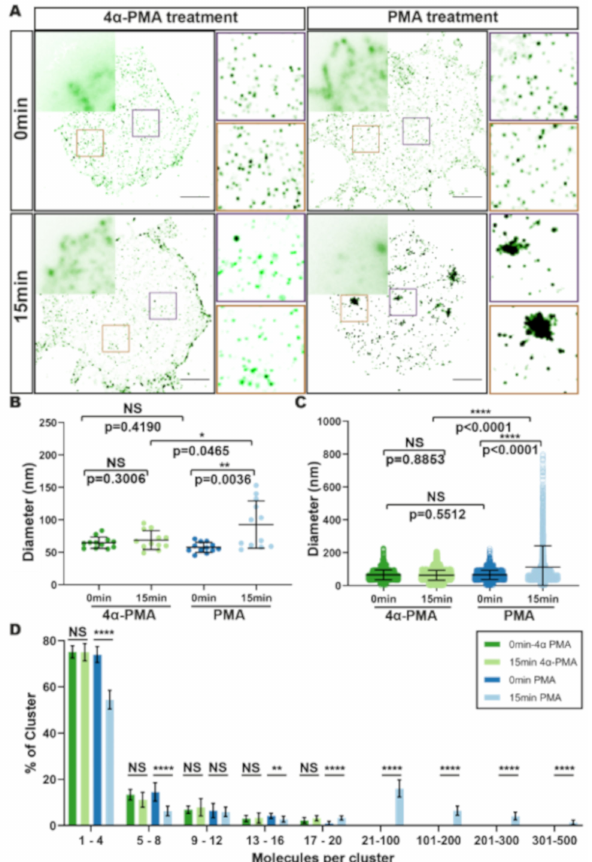
Figure 2. CD4 reorganisation in response to PMA and 4 α -PMA. ( A ) Representative TIRF ( top left corner ) and TIRF-STORM (bottom) images of CD4 clusters in SupT1-R5 cells following treatment for 0 min ( top ) or 15 min ( bottom ) with 4 α -PMA ( left ) or PMA ( right ). Insets show magni- fied TIRF-STORM images of the indicated regions. Scale bar = 2 µ m. ( B , C ) Quantification of CD4 cluster diameters; ( B ) each dot represents the average cluster diameter per cell and ( C ) each dot represents the diameter of individual clusters. 15 cells were measured per condition; bars indicate the mean ± SD. ( D ) Molecule counting of CD4 clusters. Each bar represents the mean cluster fraction displaying the indicated ranges of molecules per cluster. Data are representative of at least three independent experiments. Bars represent mean ± SD. * p < 0.05; ** p < 0.01; **** p <